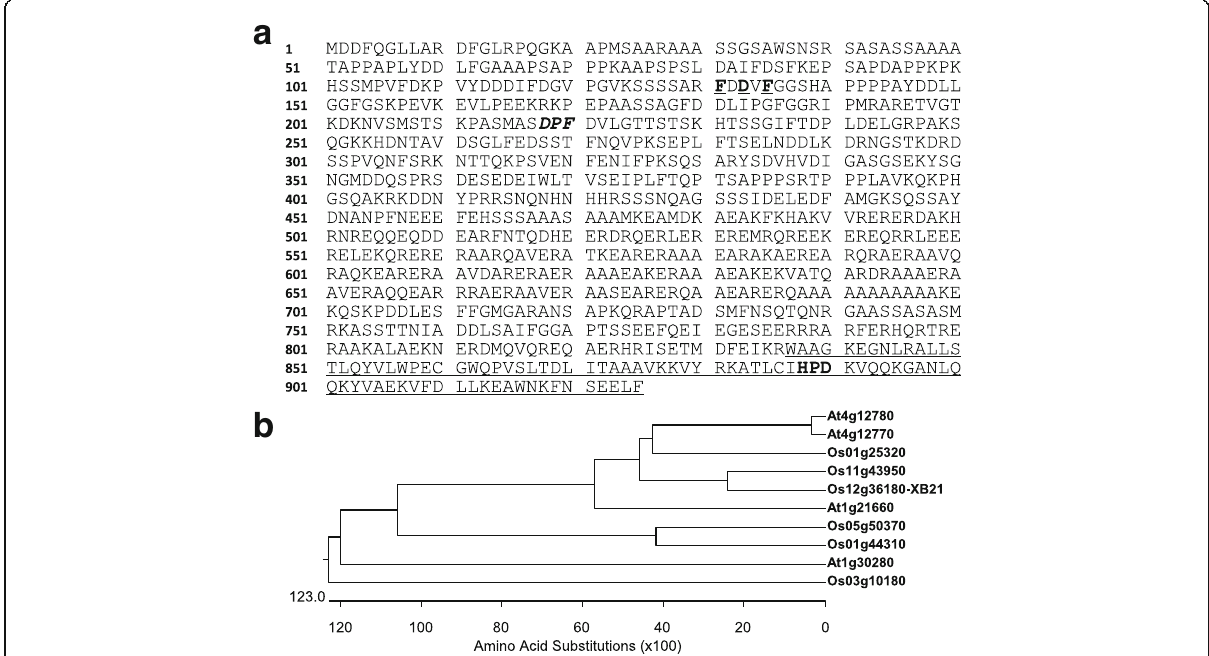
Fig. 1 Deduced amino acid sequence of XB21 and phylogenetic analysis of XB21 and type III J-proteins from rice and Arabidopsis . a The XB21 protein has a C-terminal J-domain similar to auxilin. The auxilin-like-C-terminal domain including a J-domain is underlined. Underlined bolds and bold italic indicate an FxD/NxF motif and a DPF AP-2 binding motif, respectively. b Phylogenetic relationships among XB21 and type III J-proteins from rice and Arabidopsis . For determining phylogenetic relationships, protein sequences of putative plant proteins related to type III J-proteins were aligned and then used in ClustalW. Ten thousand bootstrap replicates were performed. At4g12780, At4g12770, At1g21660, and At1g30280 from Arabidopsis ; and Os01g25320, Os11g43950, Os05g50370, Os01g44310, Os03g10180, and Os12g36180 (XB21) from